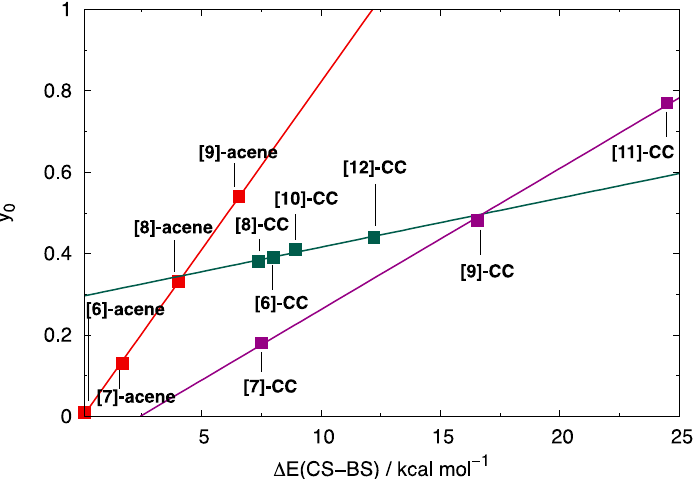
Figure 3. Correlation between the y 0 (PUB3LYP) level and the computed stabilization of the BS structure with respect to the CS structure, both optimized at B3LYP/6-31G* level: (red squares) [n]-acenes ; (green squares) even [n]-CCs ; (purple squares) odd [n]-CCs .